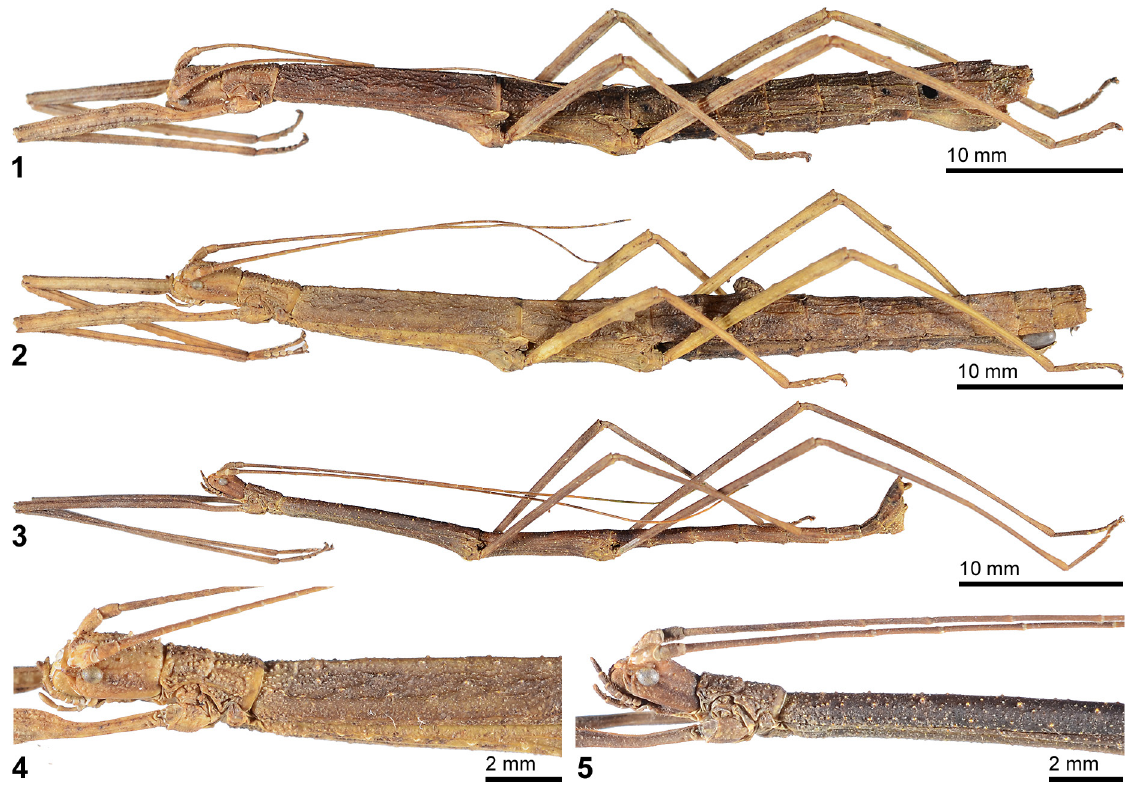
Figs 1–5. Lobolibethra carbonelli sp. nov. 1 . ♀, PT (FH, 0569-1). 2 . ♀, PT (FH, 0569-3). 3 . ♂, PT (FH, 0569-15). 4 . ♀, PT: detail of head and thorax in lateral view (FH, 0569-3). 5 . ♂, PT: detail of head and thorax in lateral view (FH,